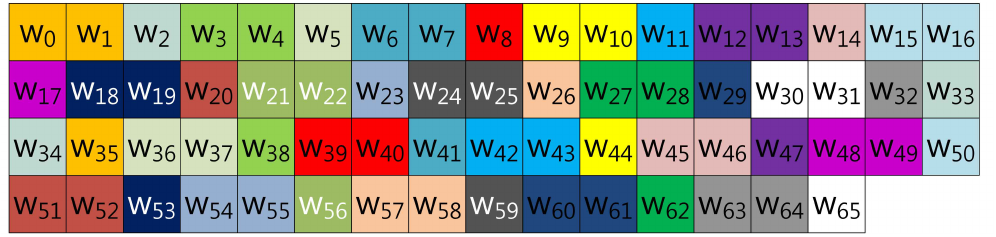
Figure 6. Look-up table structure of the (size-optimized) proposed method in block form for 3NAF (version